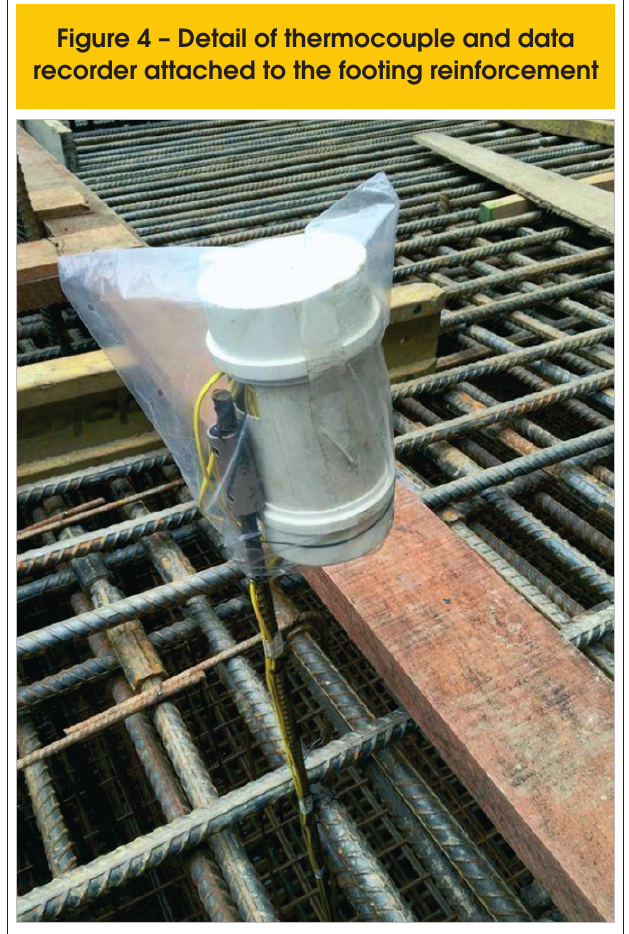
Figure 4 – Detail of thermocouple and data recorder attached to the footing